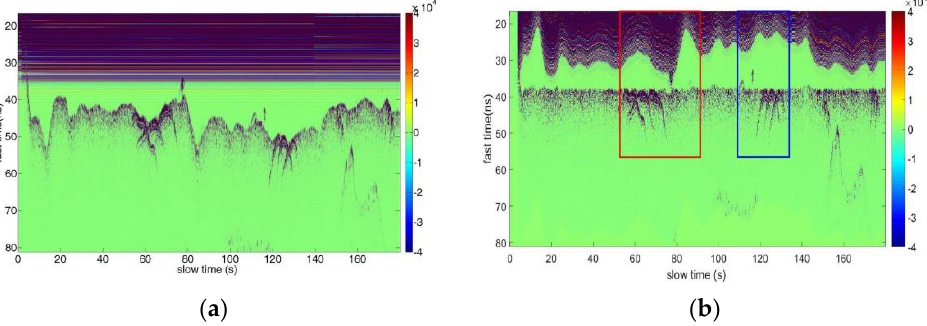
Figure 11. Example of altitude compensation (after [34]): ( a ) Before compensation, ( b ) after